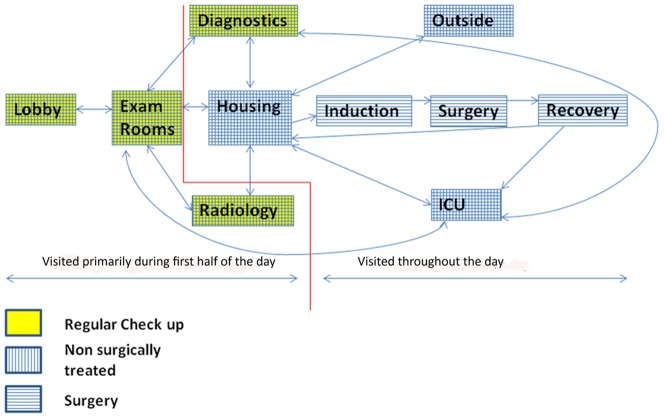
Patient movement inside the hospital.Patients seen for regular exams (yellow) are limited to the lobby, diagnostics and radiology. Patients seen for non-surgical problems (vertical lines) may be housed in wards or in the ICU and are taken outside for walks. Patients coming to WSU VTH for surgery (horizontal lines) have additional movements to the induction, surgery and recovery rooms.